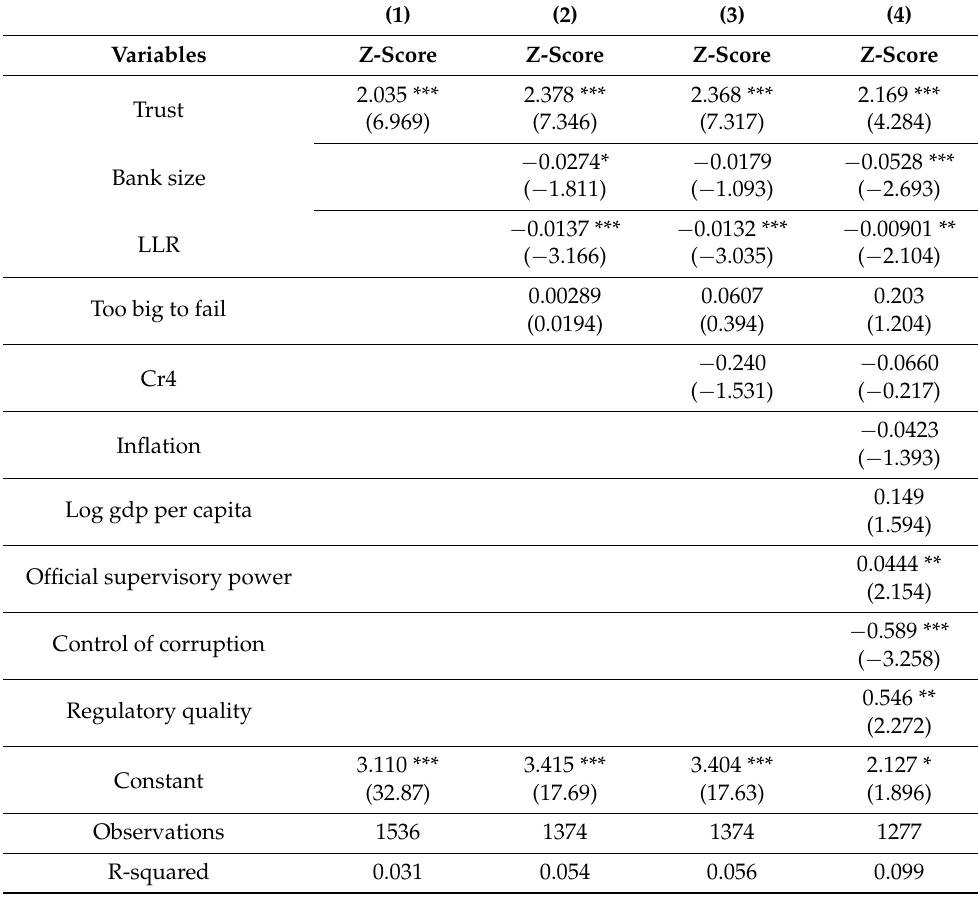
Table 4. Benchmark model—Trust.